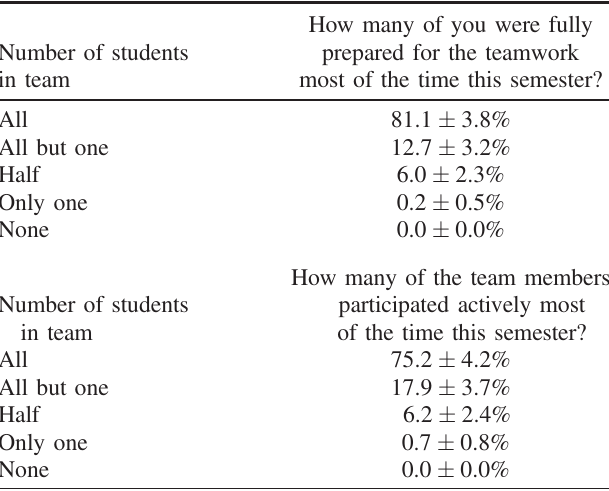
TABLE II. Student responses to the final reflection question in the Fall 2020 semester about team participation and preparedness. The uncertainty is given by the 95% binomial confidence interval with n ¼ 403